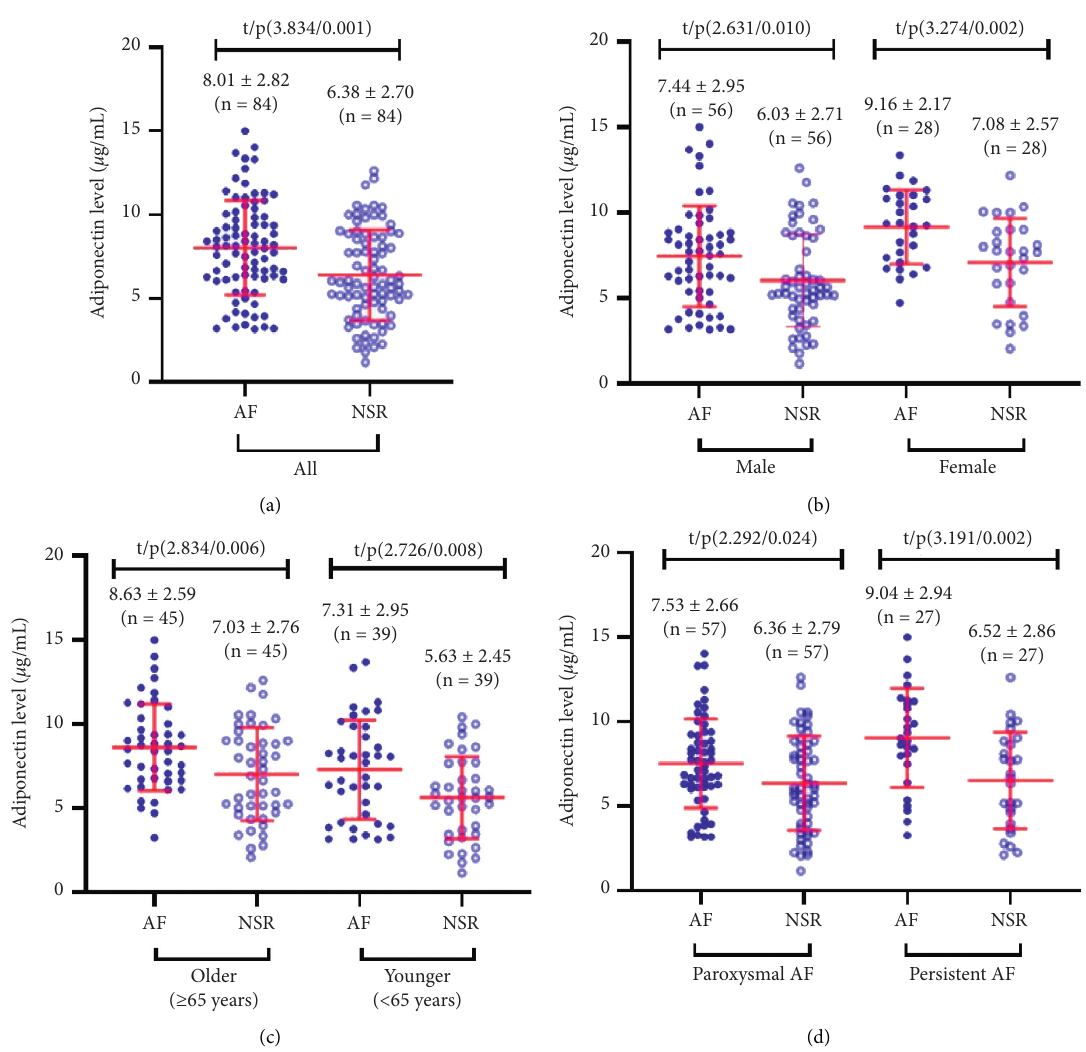
Figure 1: Serum adiponectin levels in patients with AF and controls with NSR: (a) scattergram comparing the serum adiponectin levels in the overall participants; (b) scattergram comparing the serum adiponectin levels according to the gender of the participants; (c) scattergram comparing the serum adiponectin levels according to the age of the participants; (d) scattergram comparing the serum adiponectin levels according to the type of